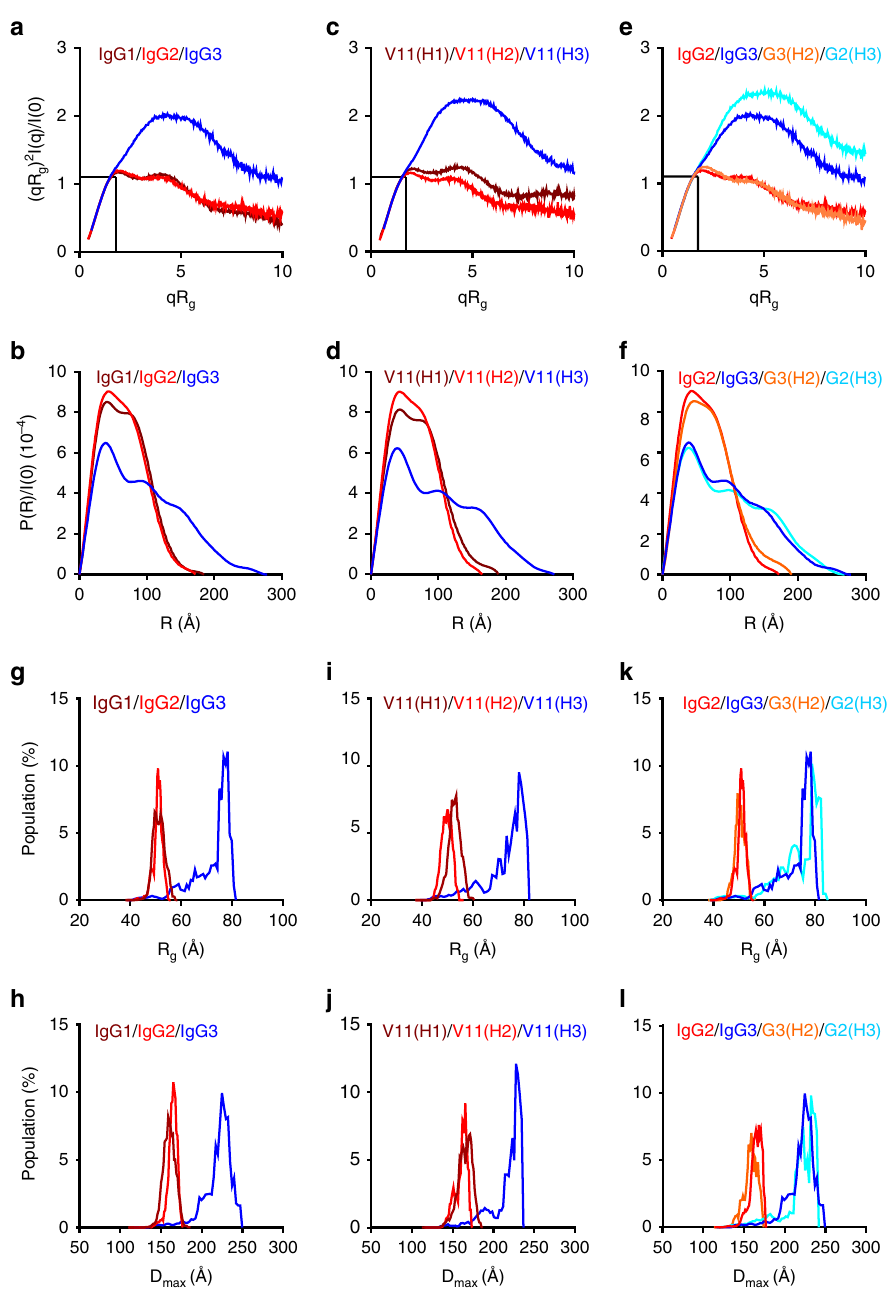
Fig. 4 The superior fl exibility of IgG3 CH1-hinge. a – f Dimensionless Kratky plots ( a , c , e ) and normalized interatomic distance distribution (P(R)/I(0)) ( b , d , f ) of anti-mCD40 antibodies of indicated constant domains (at the highest tested concentrations). In dimensionless Kratky plots, the position of ffiffiffi p Guinier – Kratky points ( 3 , 1.103) are labeled with black dashed lines. g – l The distribution of R g ( g, i, k ) and D max ( h , j , l ) in the optimized ensembles generated in EOM analysis of the indicated antibodies (at the lowest tested concentrations). A representative of two independent experiments is